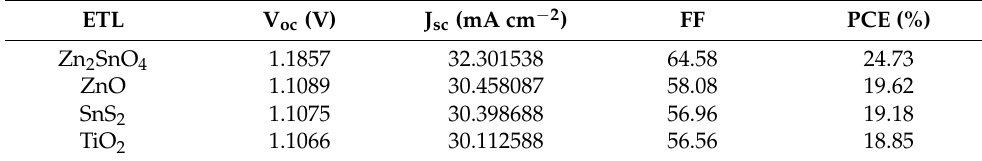
Figure 10. J-V curves for different ETL materials. Table 5. Device performance with different ETL